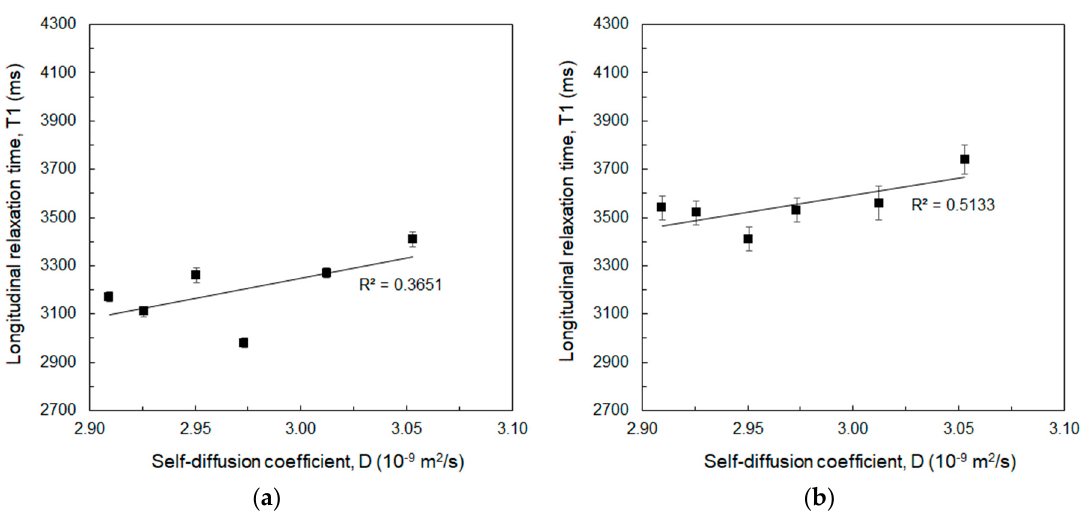
Figure 2. Longitudinal relaxation time (T1) as a function of the water self-diffusion coefficient measured for DVS/HA mass ratio solutions without Gd-DTPA at: ( a ) 20 MHz; ( b ) 60 MHz. Linear regression lines with values of the determination coefficients are displayed.